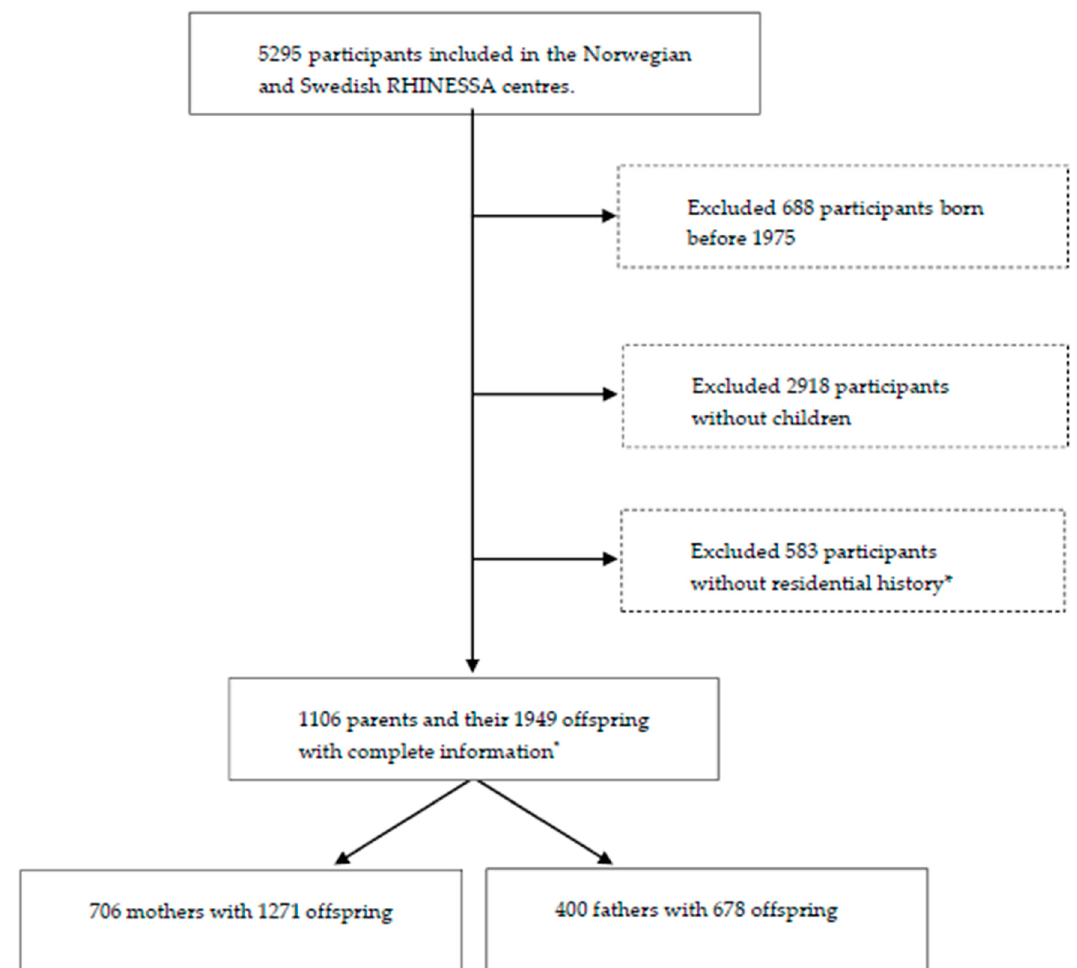
Figure 1. Flowchart of the Respiratory Health in Northern Europe, Spain and Australia (RHINESSA) generation study population. * Lack of residential history due to lack of registered addresses in the population registries or lack of consent to address history retrieval.